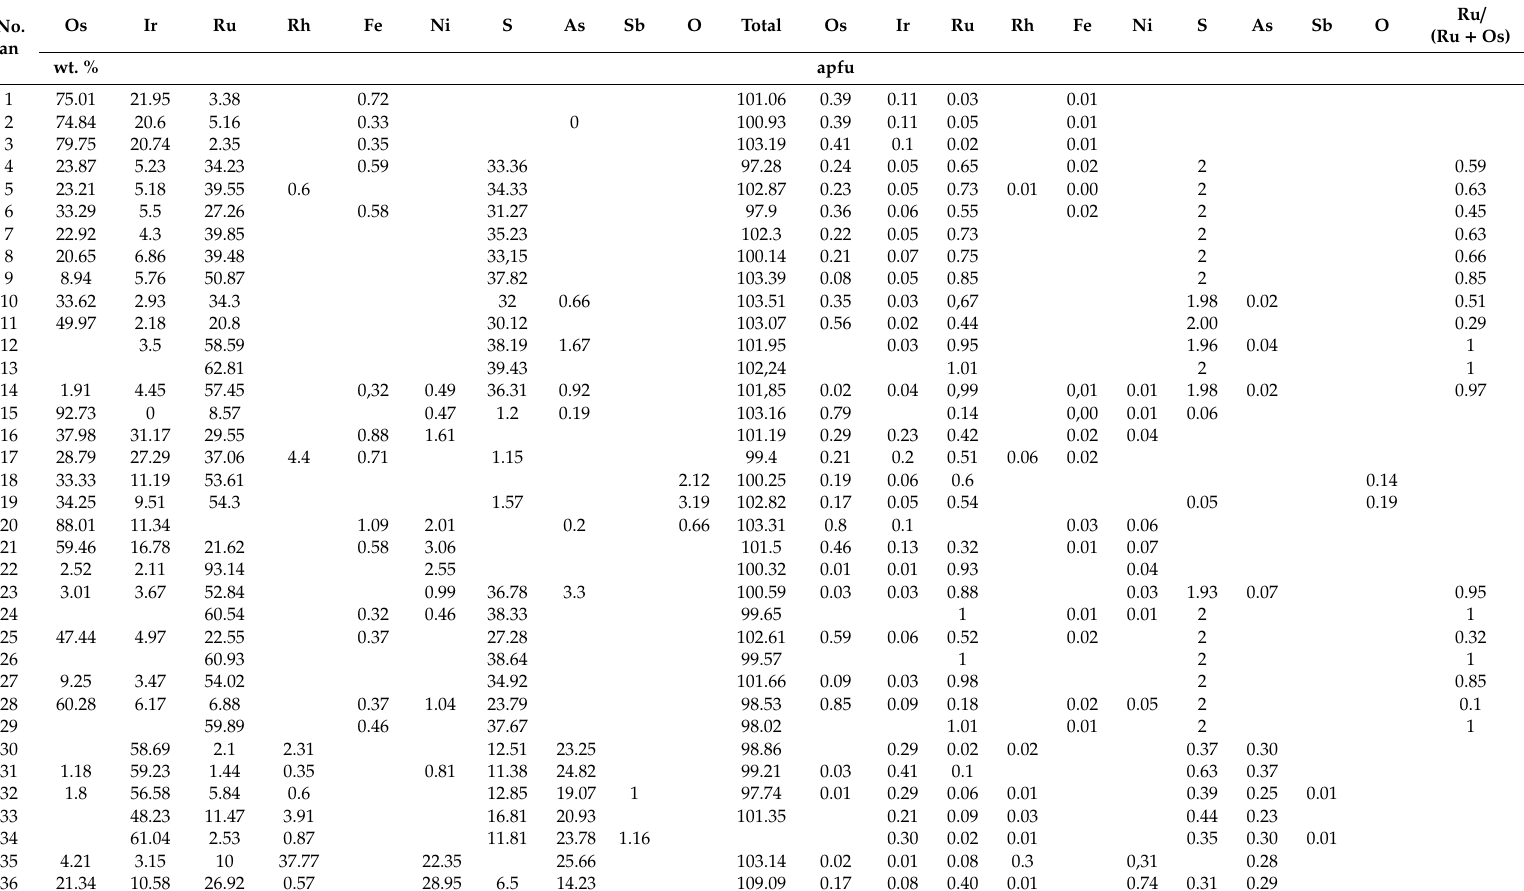
Table 4. Representative composition of platinum-group elements in the chromitite from the Ulan-Sar’dag ophiolitic massif. No.